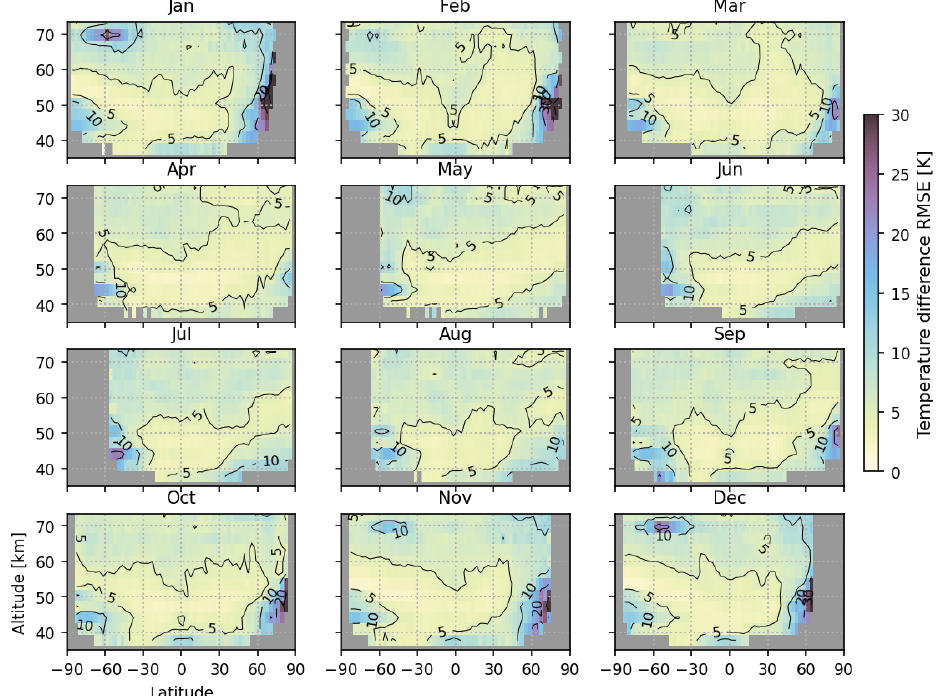
Figure 17. Monthly RMSE between temperature retrieved from O 2 1 (cid:49) airglow in nominal limb orbits and the MIPAS nominal mode temperature